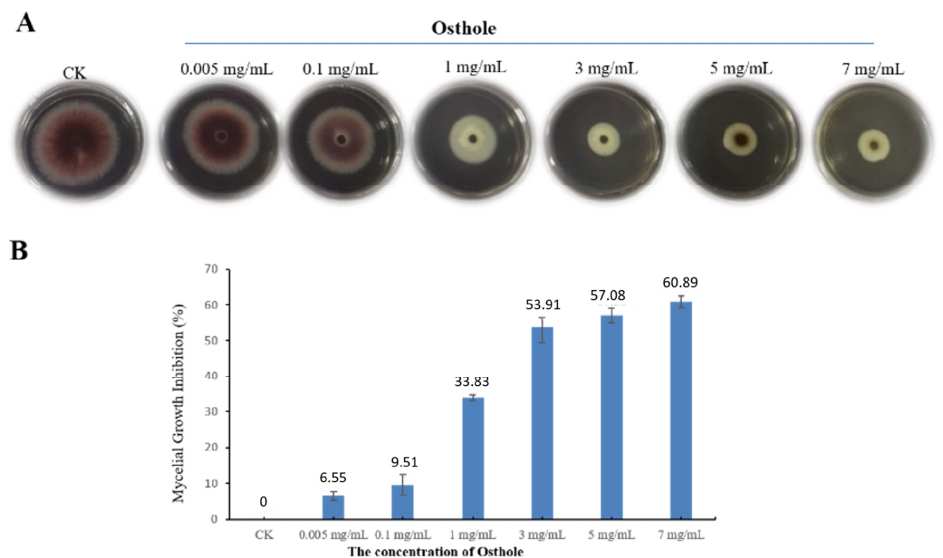
Figure 2. The inhibitory effect of osthole at different concentrations on F. oxysporum . The colony morphology ( A ) and the mycelial growth inhibition ( B ) of F. oxysporum in media containing osthole, 5 days after inoculation.